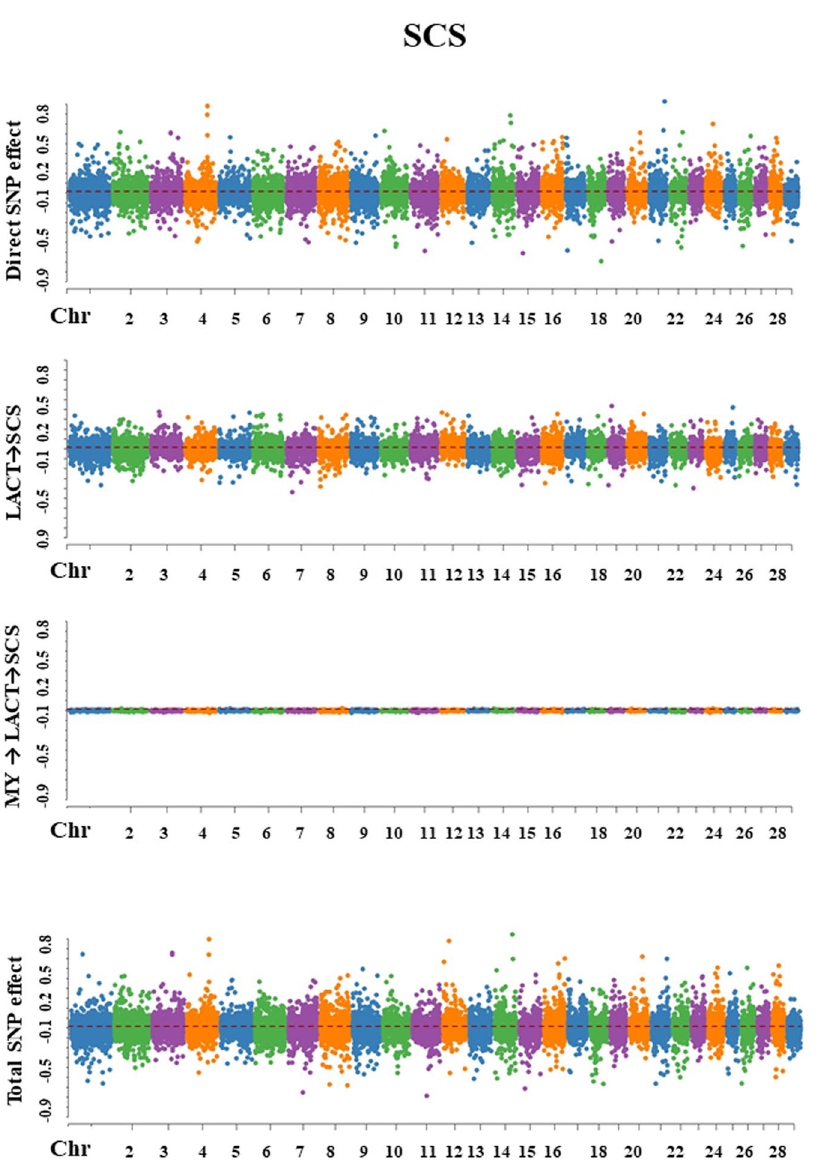
Figure 5. Manhattan plots for SNP effects on somatic cell score obtained using SEM-GWAS based on the network structure learned by Hill-Climbing algorithm. MY: milk yield; LACT: lactose; SCS: somatic cell